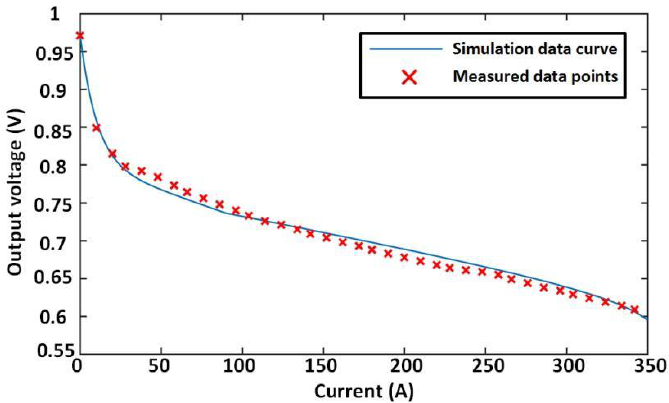
Figure 9. Comparison of simulation data and measured data of HFC electrochemical mechanism model. Table 6. The error between the simulated data and the actual data.